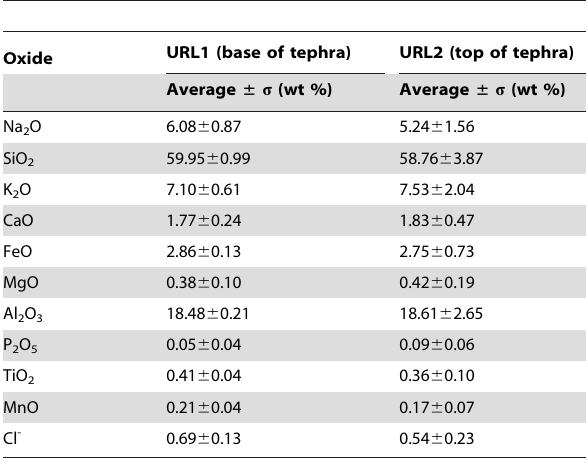
Table 1. Geochemical analyses of major and minor element concentrations for tephra samples URL1 and URL2.